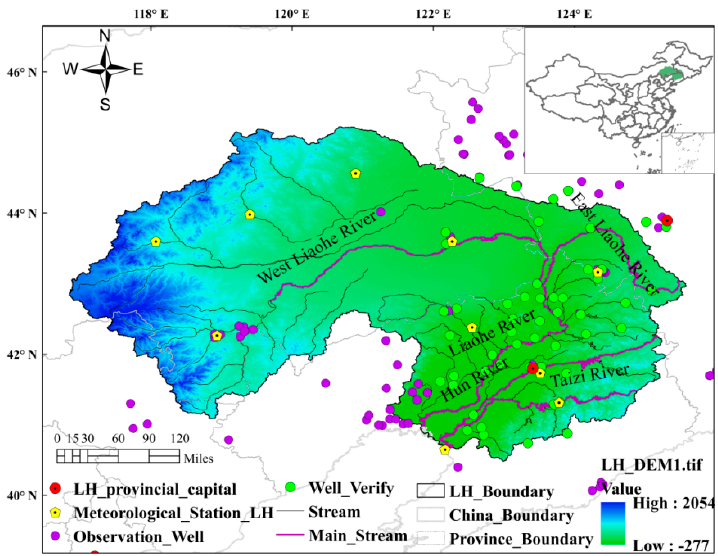
Figure 2. Distribution map of the Liao River Basin.